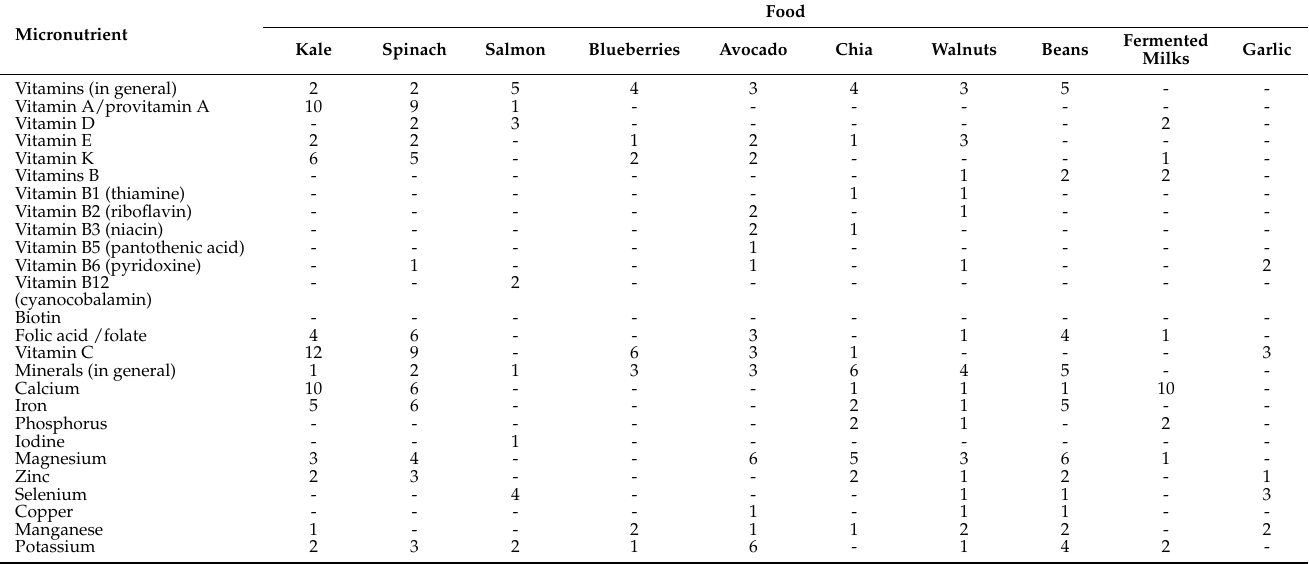
Table 11. Micronutrients of ‘superfoods’ and number of selected websites that mentioned each one.